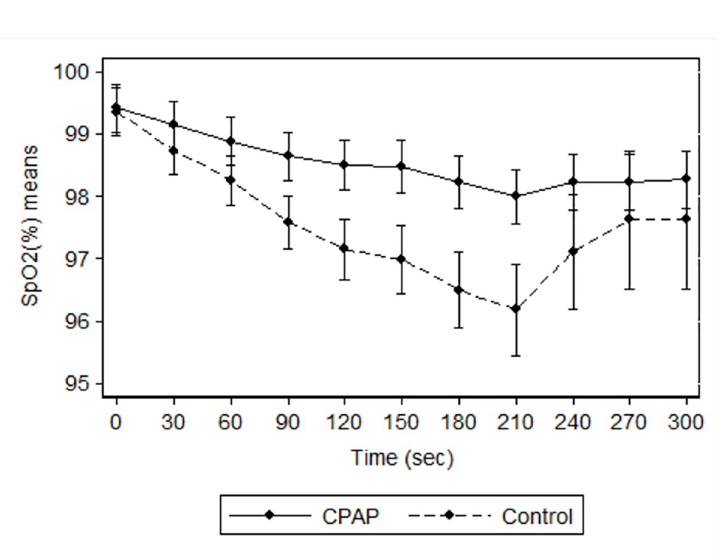
Fig 3. Repeated-measures saturation values curves. Mean SpO 2 values in children with either CPAP ventilation and passive CPAP oxygenation (10 cmH 2 O) or no positive airway pressure (0 cmH 2 O) during anaesthesia induction for elective surgery and their respective confidence intervals in the two-group interaction (p ranging from 0.047 to < 0.001 for the interaction between the curves in the 60–210 s interval).